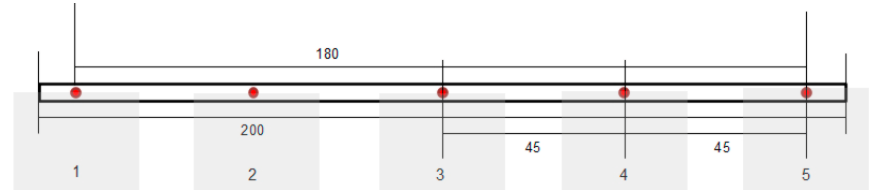
Figure 1. Ultrasonic sensor setup and dimensions of the mounted road scanner bar (cm), including the spacing of the ultrasound sensors (red), with a central mounting point at sensor 3, in combination with their maximal detection beam width (grey).